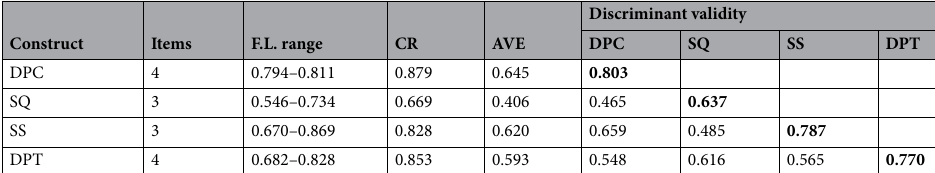
Table 2. Results of the reliability and validity tests. The bold values shown on the diagonal are √ AVE s, and the values under the bold value represent the Pearson correlation coefficients between constructs. DPC doctor–patient communication, SQ service quality, SS service satisfaction, DPT doctor–patient trust, F.L. factor loading, CR composite reliability, AVE average of variance extracted.